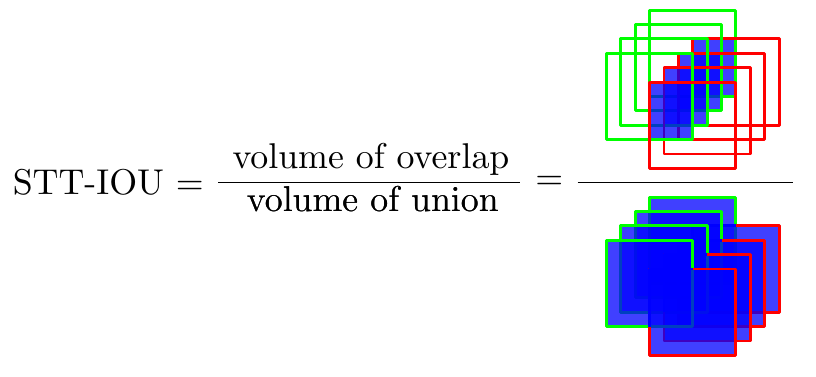
Figure 7. Spatio-temporal tube IOU (STT-IOU).